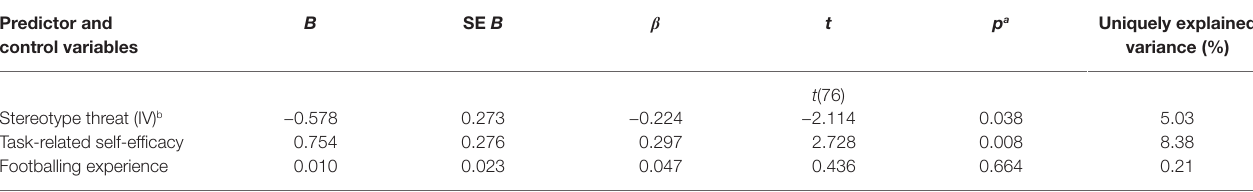
TABLE 2 | Regression analysis with scored hits as criterion. Predictor and control variables